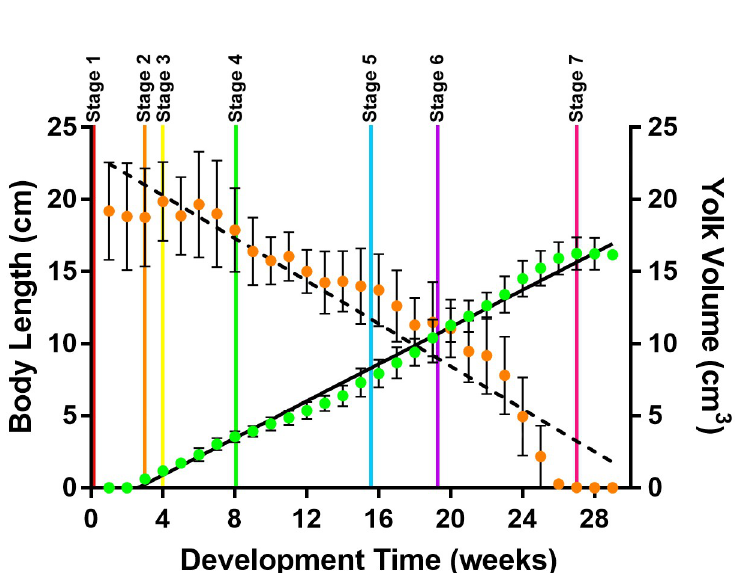
Fig 9. S . stellaris body length and external yolk sac volume across the 7 developmental stages. Total body length (cm, green, Y = 0.6416X − 1.674, R 2 = 0.9898, r = 0.9949) and total external yolk sac volume (cm 3 , orange, Y